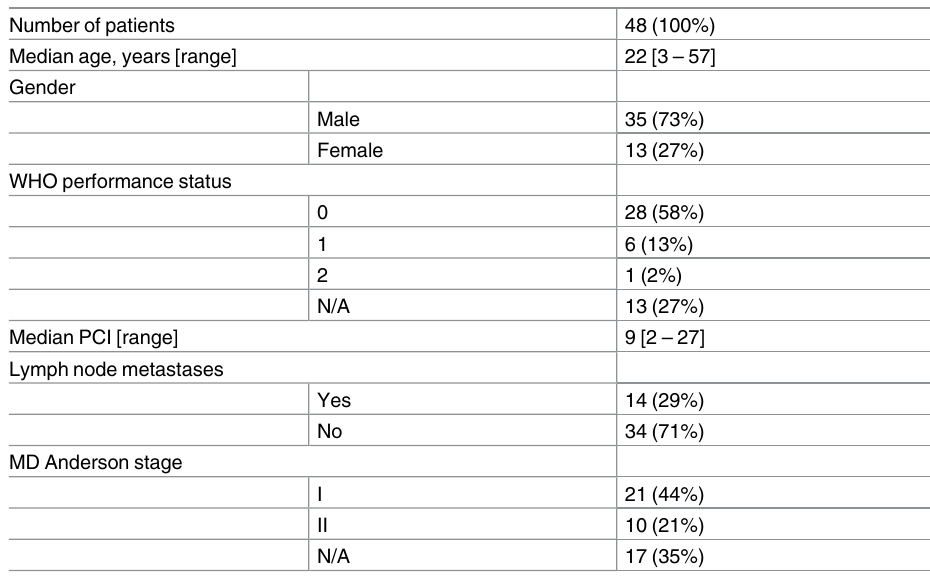
Table 1. Patients and tumors’ characteristics.